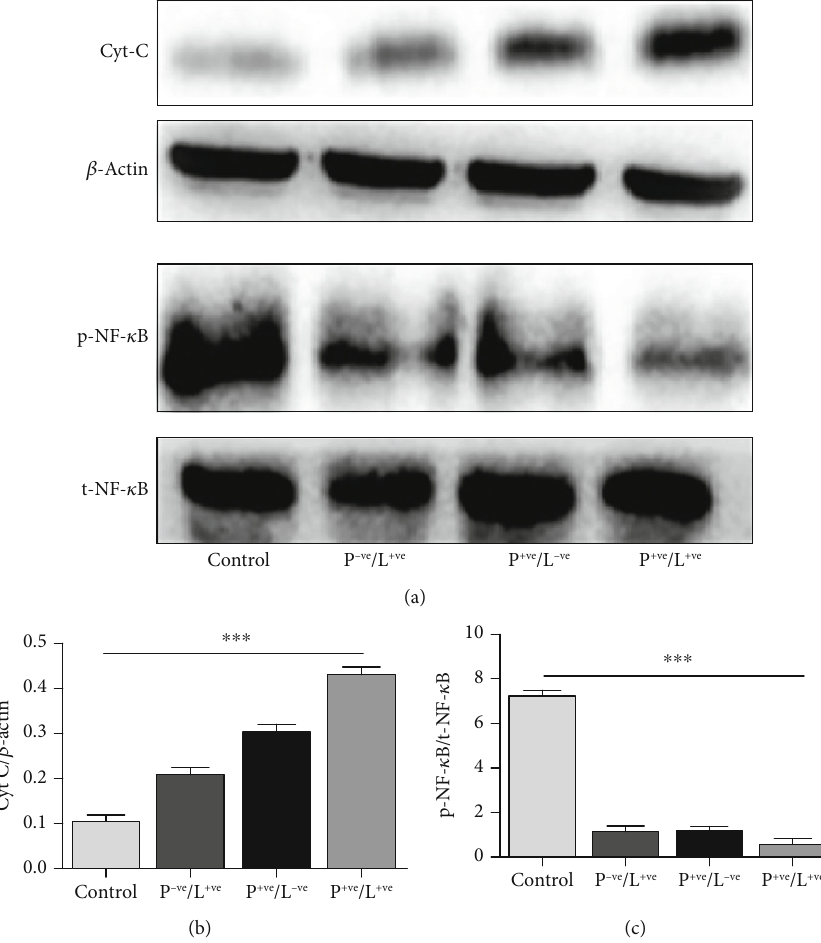
Figure 5: (a) Western blotting expression of cytochrome C and TNF- κβ in TE 354.T cells following AE-PDT. The cells were treated with 5 μ M AE, irradiated for 10 min, and protein lysates were collected 12h later for western blotting assays. β -Actin was used as an internal control. The graphs represent the quantitative analysis of (b) cytochrome C changes relative to β -actin and (c) p-NF- κ B relative to total TNF-kB. ∗∗∗ p < 0 : 0001 . Protein level was expressed as mean ± SD from three independent